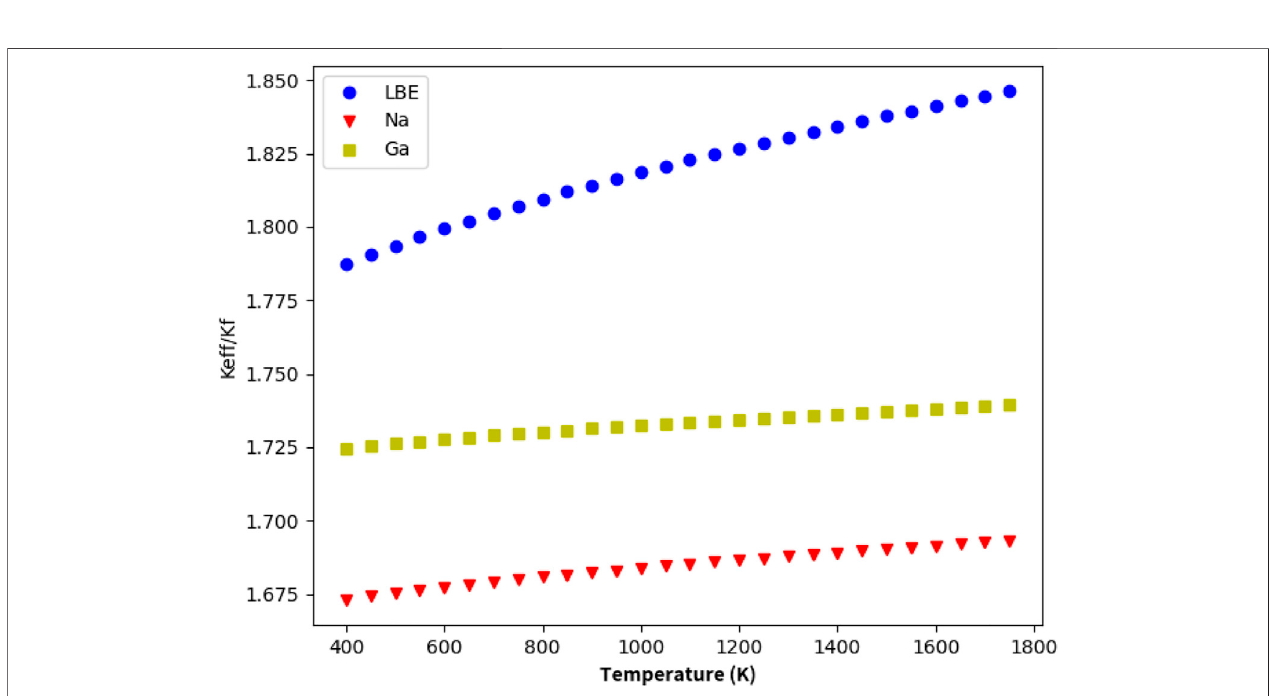
FIGURE 5 | Thermal conductivity change with temperature ( φ (cid:2) 0.2, r (cid:2) 20 nm).